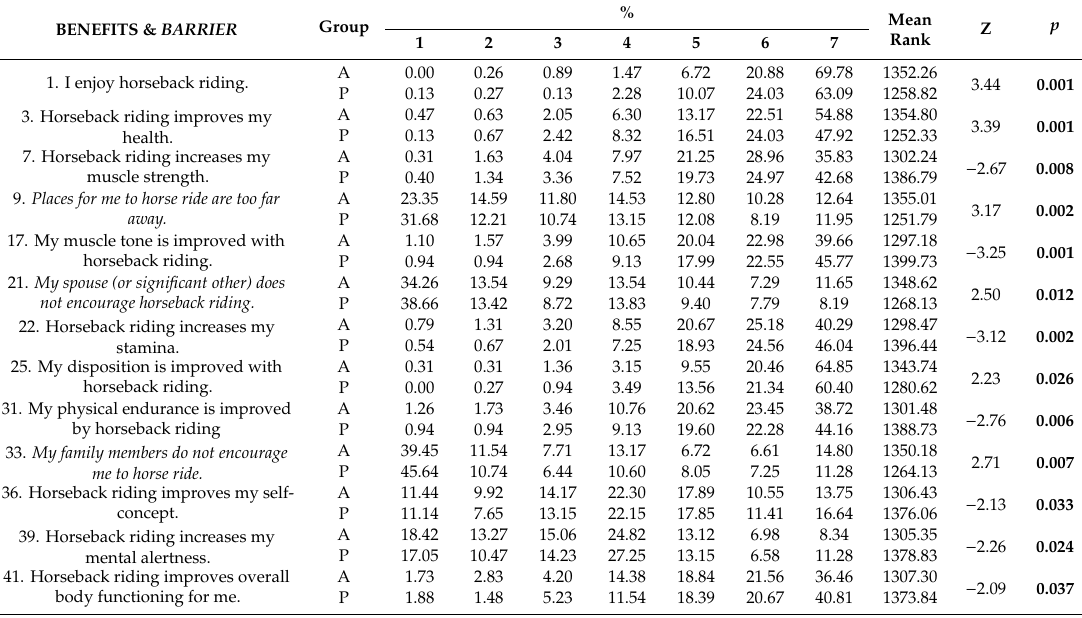
Table 5. Comparison of all participants based on a specialized degree: amateurs (n = 1906) vs professionals (n = 745), ( p < 0.05). (1–7 Likert scale: 1—this issue concerns me to a very low degree; 7—this issue concerns me to a very high degree).